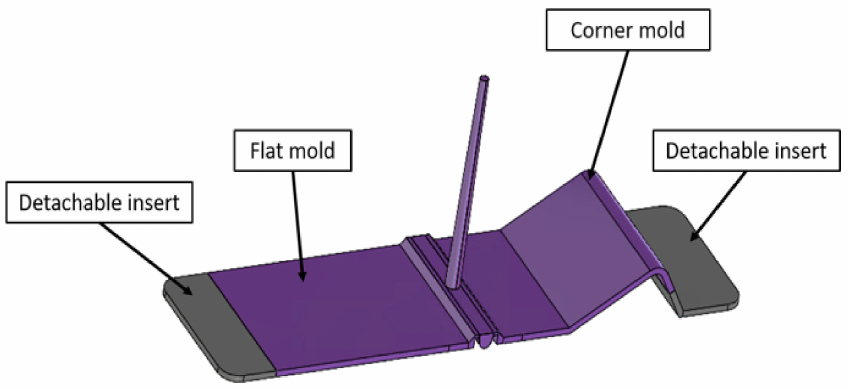
Figure 13. Location of the detachable